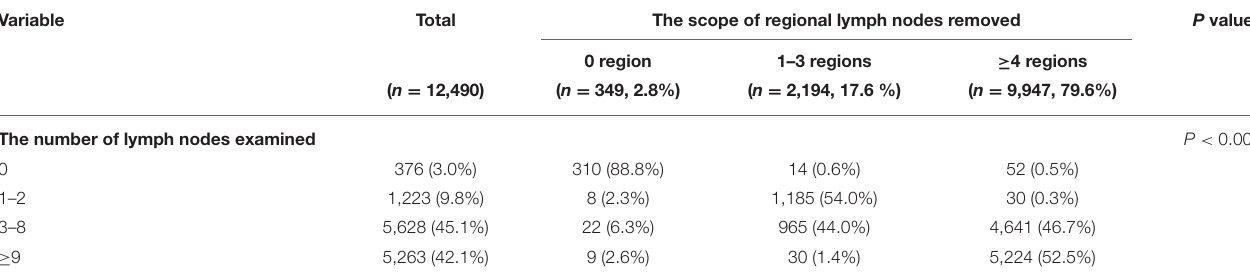
TABLE 2 | The correlation between the number of lymph nodes examined and the scope of regional lymph nodes removed. Variable Total The scope of regional lymph nodes